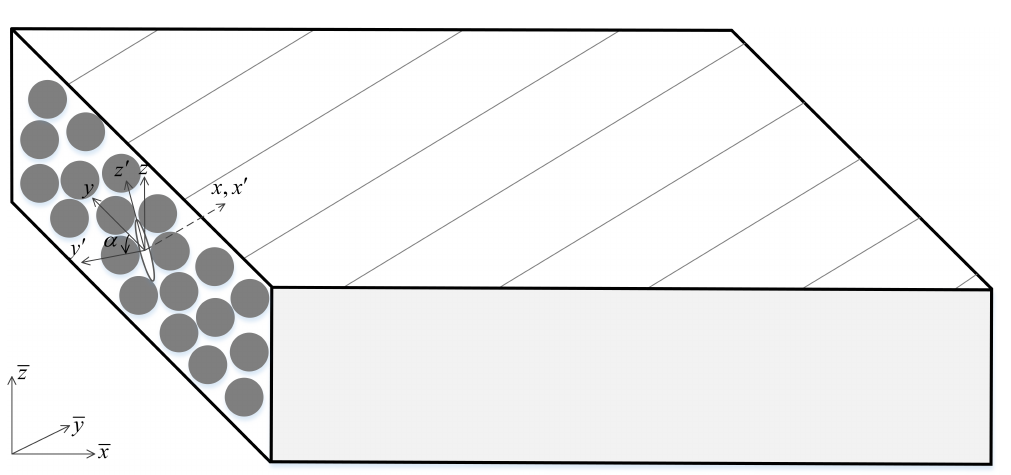
Figure 1. Three coordinate systems for considering matrix